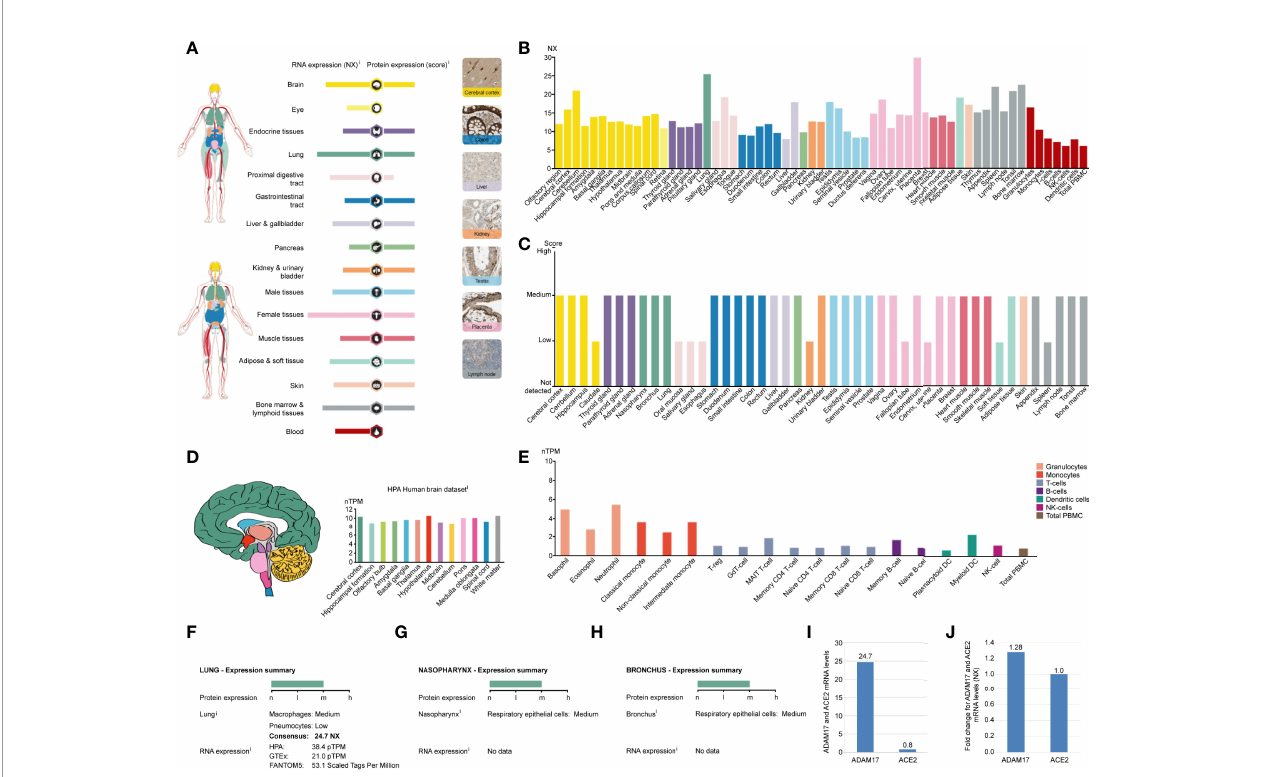
FIGURE 2 | ADAM17 expression in normal tissues. (A) The summary of ADAM17 mRNA and protein expressions. Color-coding columns are based on tissue groups, and each consists of tissues with common functional features. Respective images are the immunohistochemistry (IHC) staining of ADAM17 from the HPA in normal tissues. (B) ADAM17 mRNA expressions from normal tissues. An NX value of 1.0 is de fi ned as a threshold for ADAM17 mRNA expression. NX, normalized expression. (C) ADAM17 protein levels in normal tissues were from the HPA. Protein expression data are presented for every 44 tissues. (D) Brain mRNA expression for ADAM17. (E) Immune cell type expression for ADAM17 mRNA. The expression values were calculated as nTPM, which resulted from the internal normalization pipeline for 18 immune cell types and total PBMC (peripheral blood mononuclear cells). HPA, Human Protein Atlas. (F) Expression summary in the lungs. pTPM,